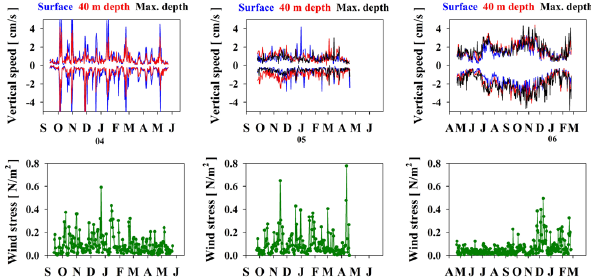
Fig. 13. (upper panel) Maximum and minimum vertical velocity and (lower panel) wind stress at different depths. Year is indicated below January